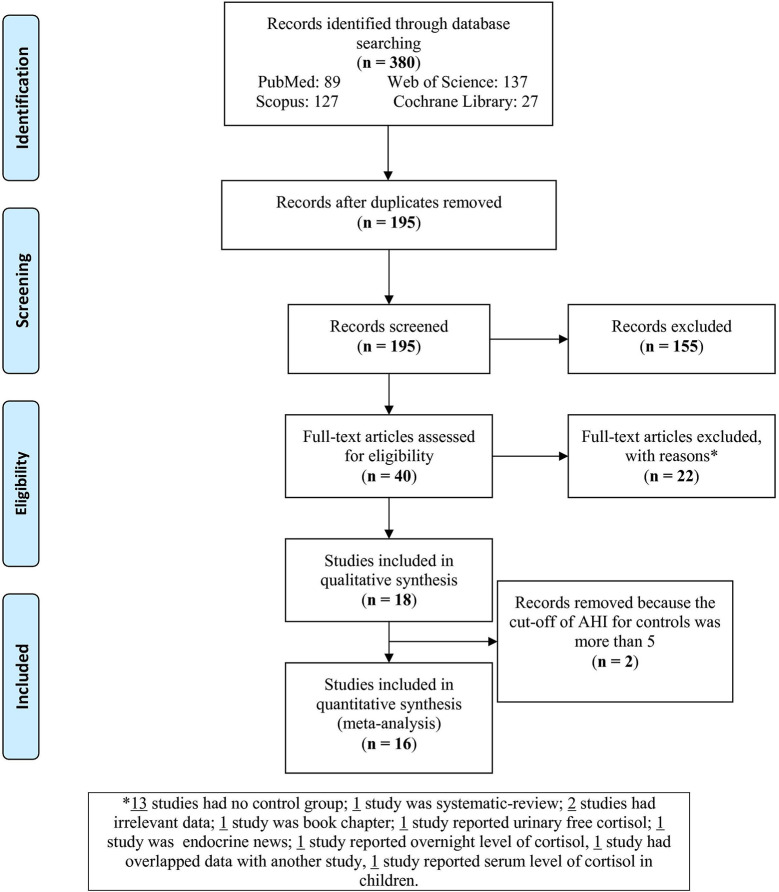
Flow chart of the study selection.